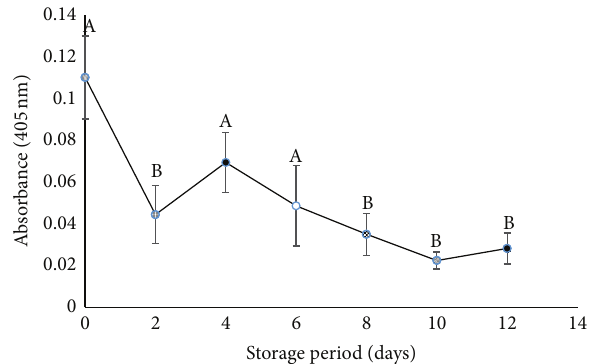
Figure 2: Superoxides in stored platelets. Values are mean ± SE of five animals/group. One-way ANOVA was performed between the groups followed by Tukey-Kramer multiple comparison test, using Graph Pad Prism 6 software, and represented in upper case at 𝑃 < 0.05 . Those not sharing the same letters are significantly